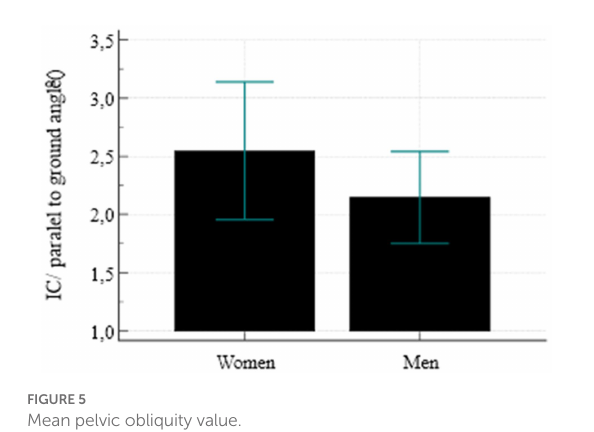
FIGURE 4 Mean value of pelvic rotation.